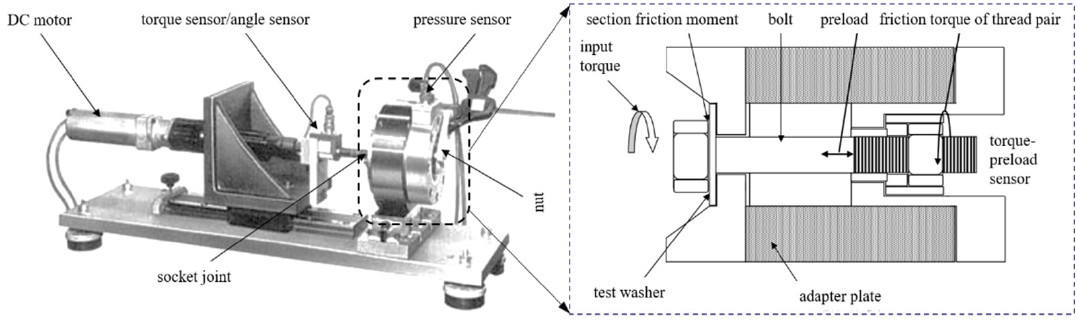
Figure 4. The tightening test system used by Nassar to measure decomposition torque [36].